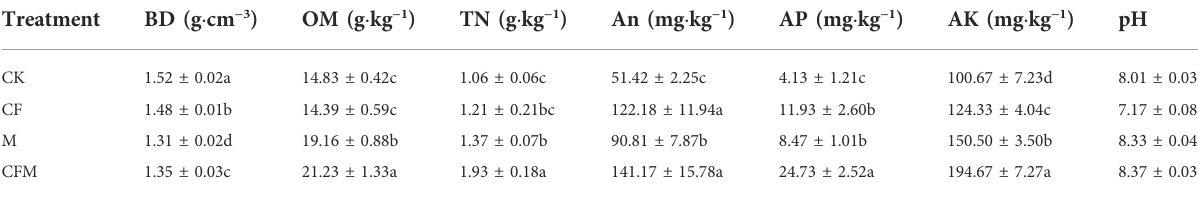
The data represent means ± standard deviation ( n = 3). Different letters in a column indicate statistically signi fi cant differences among the different treatments ( p < 0.05).